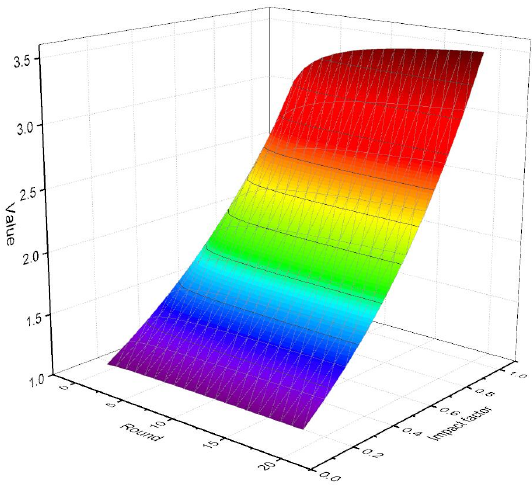
Figure 6. Participant value analysis.